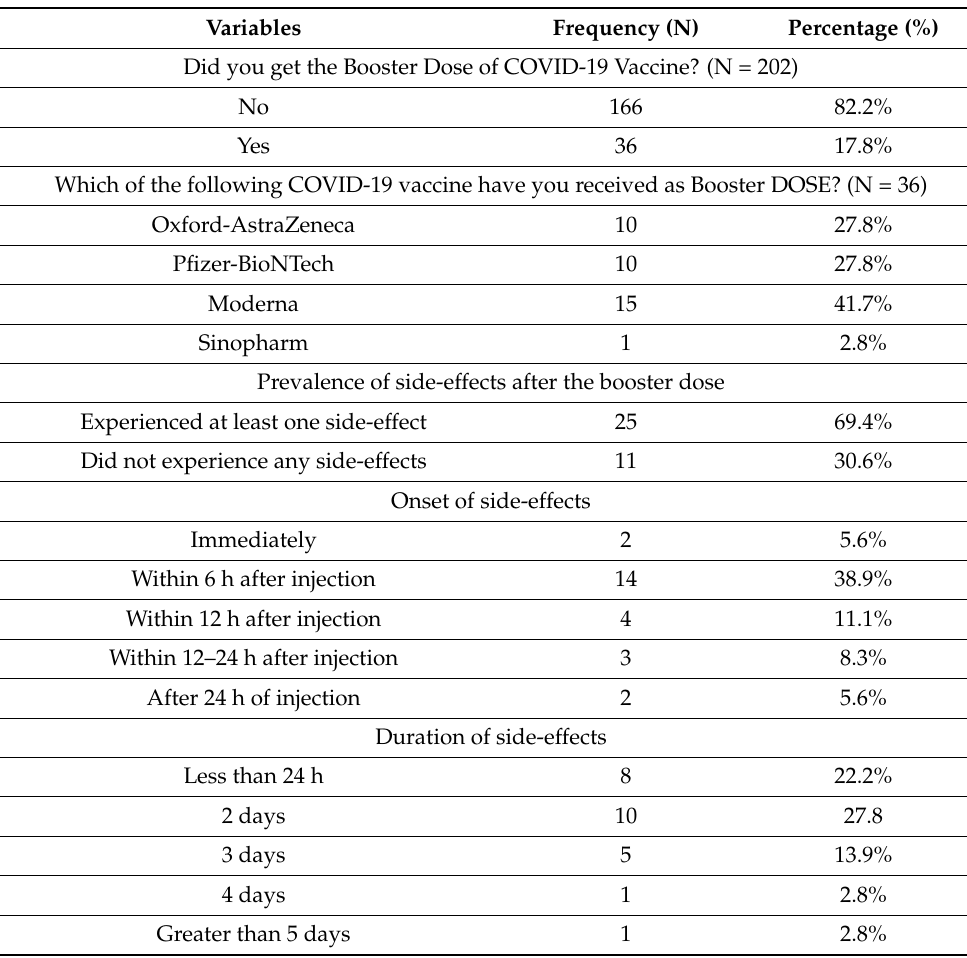
Table 6. Participants receiving the booster dose of COVID-19